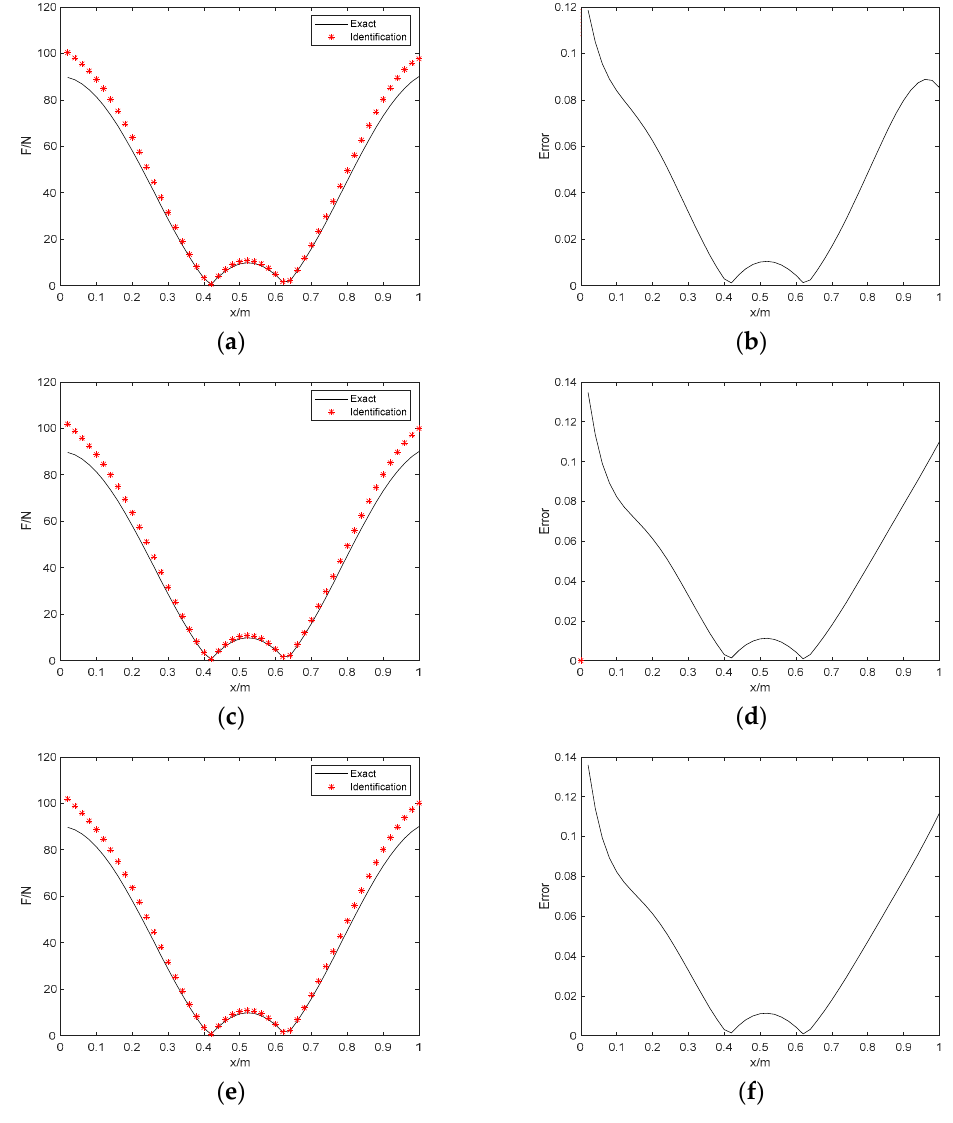
Figure 9. The identification results with 15% noise. ( a ) Proposed method; ( b ) identification error; ( c ) Tikhonov with L − curve regularization; ( d ) identification error; ( e ) Tikhonov with GCV regulariza- tion; ( f ) identification error. Table 6. Identification error in Example 3.